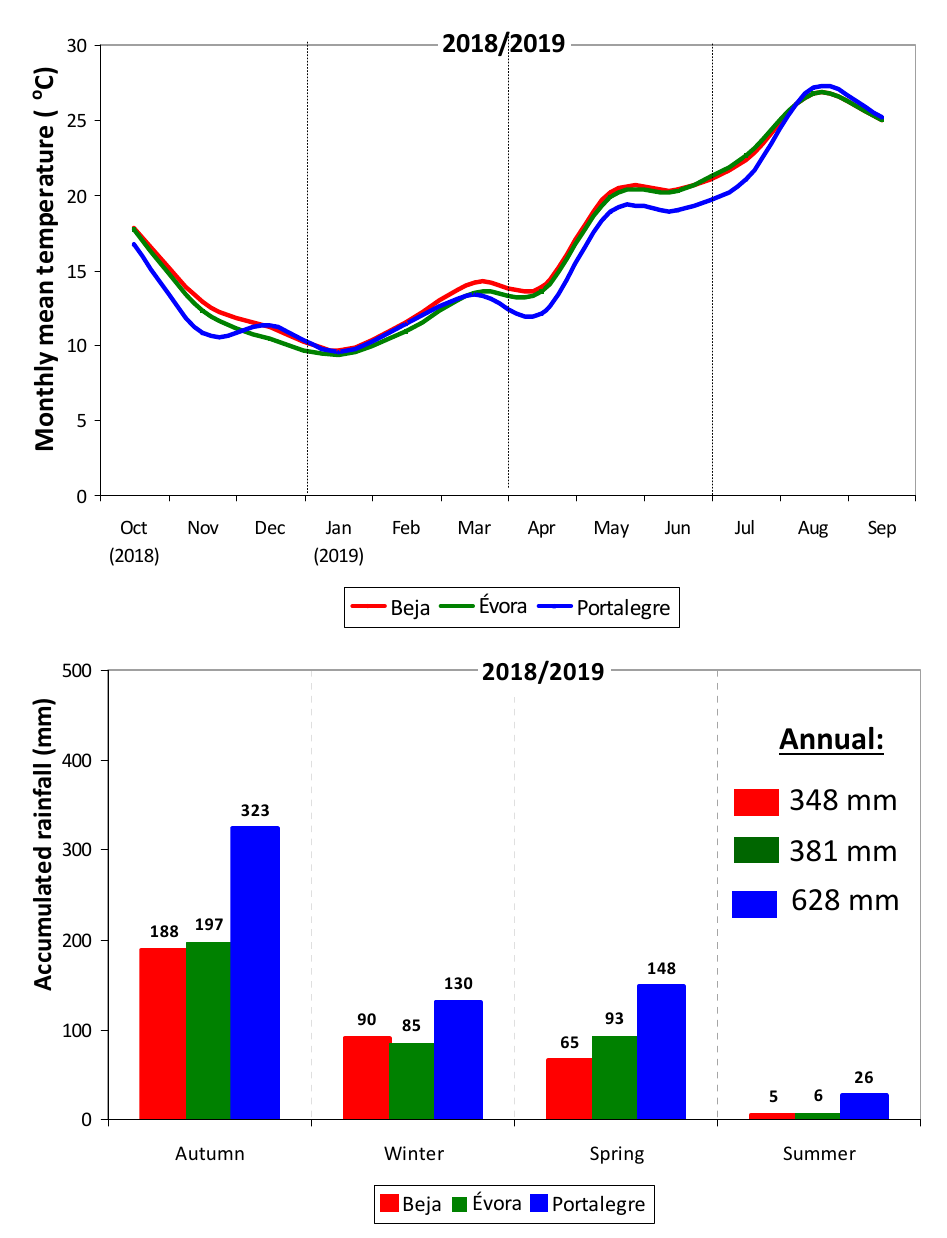
Figure 4. Thermo-pluviometric data of Beja, Évora, and Portalegre districts of the southern Alentejo region of Portugal between October 2018 and September 2019 (source: Portuguese Institute of Sea and Atmosphere).